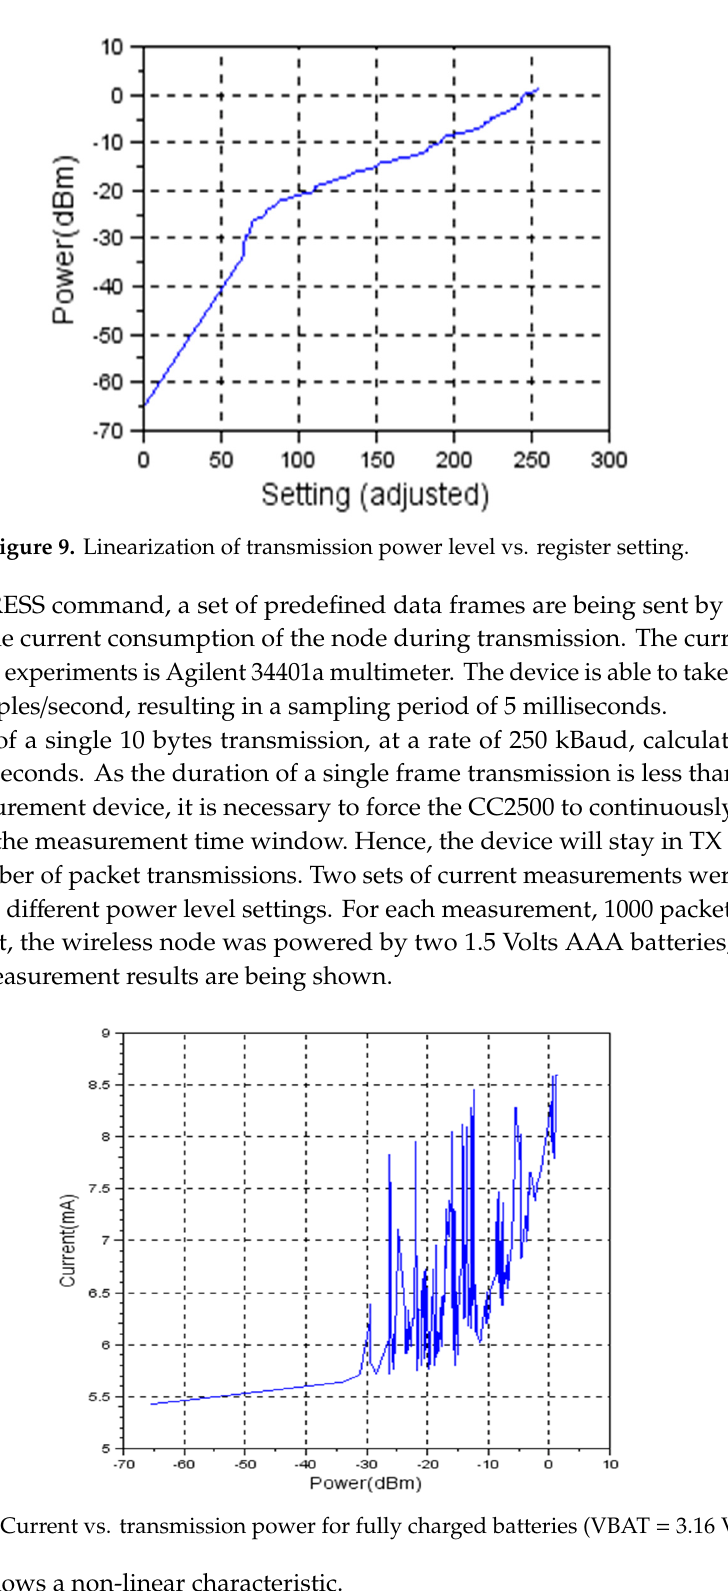
Figure 8. Non-linear variation of transmission power level vs. register setting.